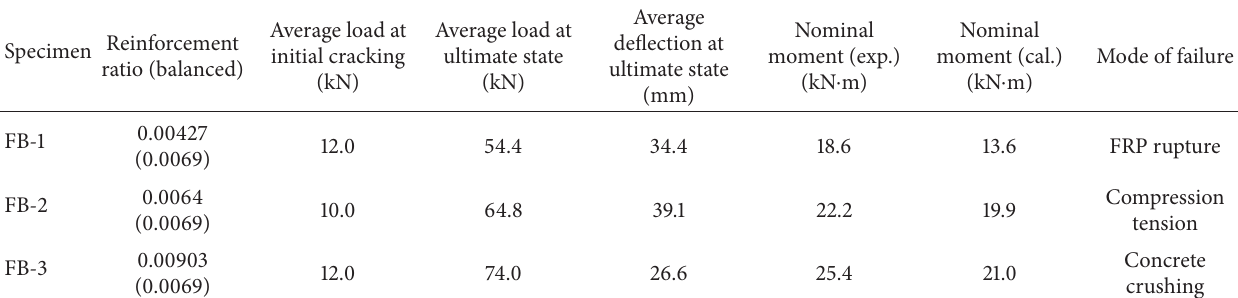
Table 2: Result of experimental test of GFRP bar reinforced concrete